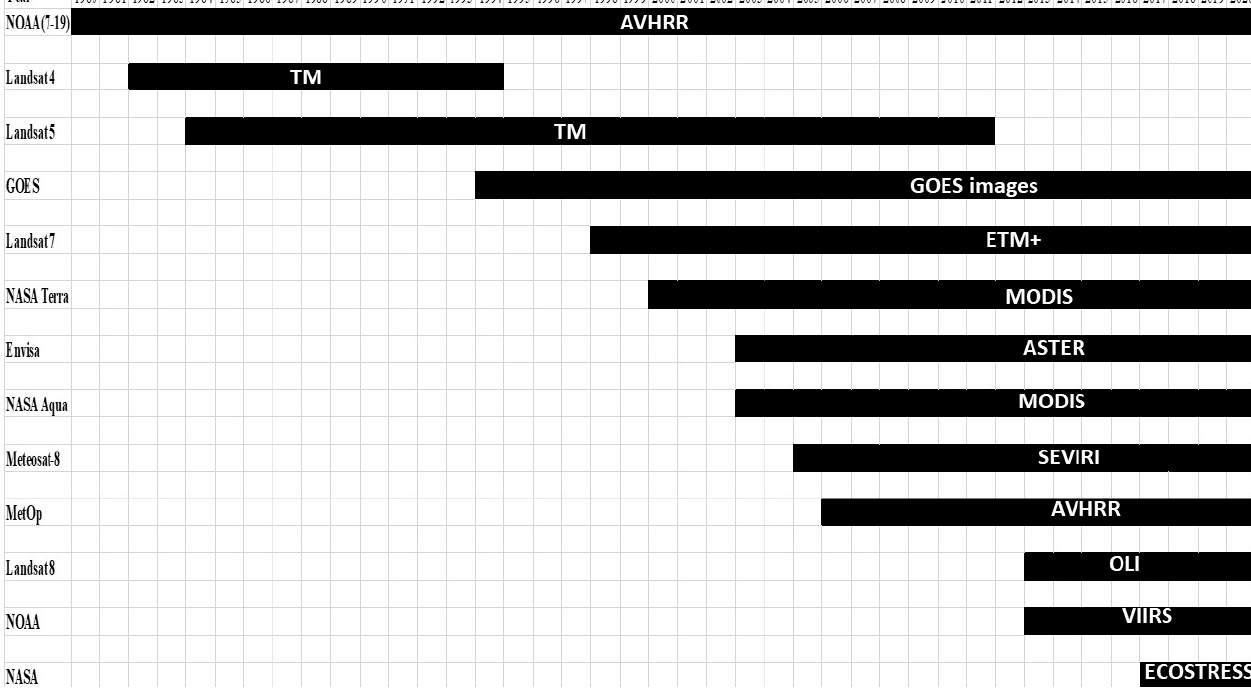
Figure 3. Timeline of satellite data availability. Data availability to 2020 indicates ongoing availability. Table 4. Proportion of reviewed UHI, UHII, and UHIE studies using various remotely sensed